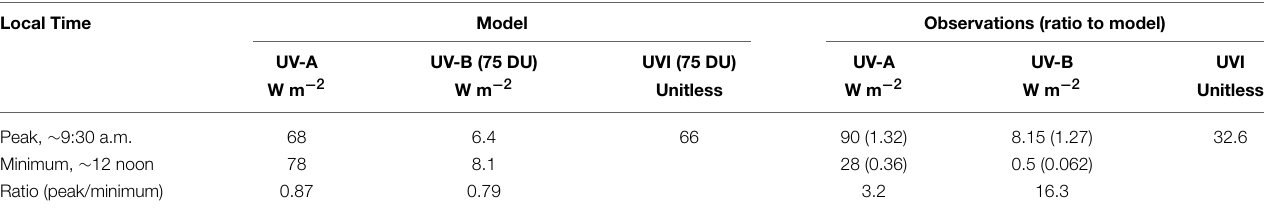
a Figure 3 of C14. Times are approximately. No correction for solar zenith angle was